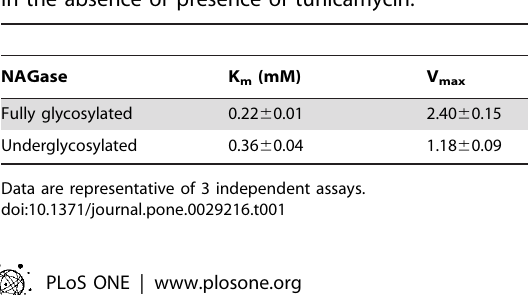
Table 1. Partial kinetic characterization of N-acetyl- b - D - glucosaminidase activity (NAGase) produced by P. brasiliensis in the absence or presence of